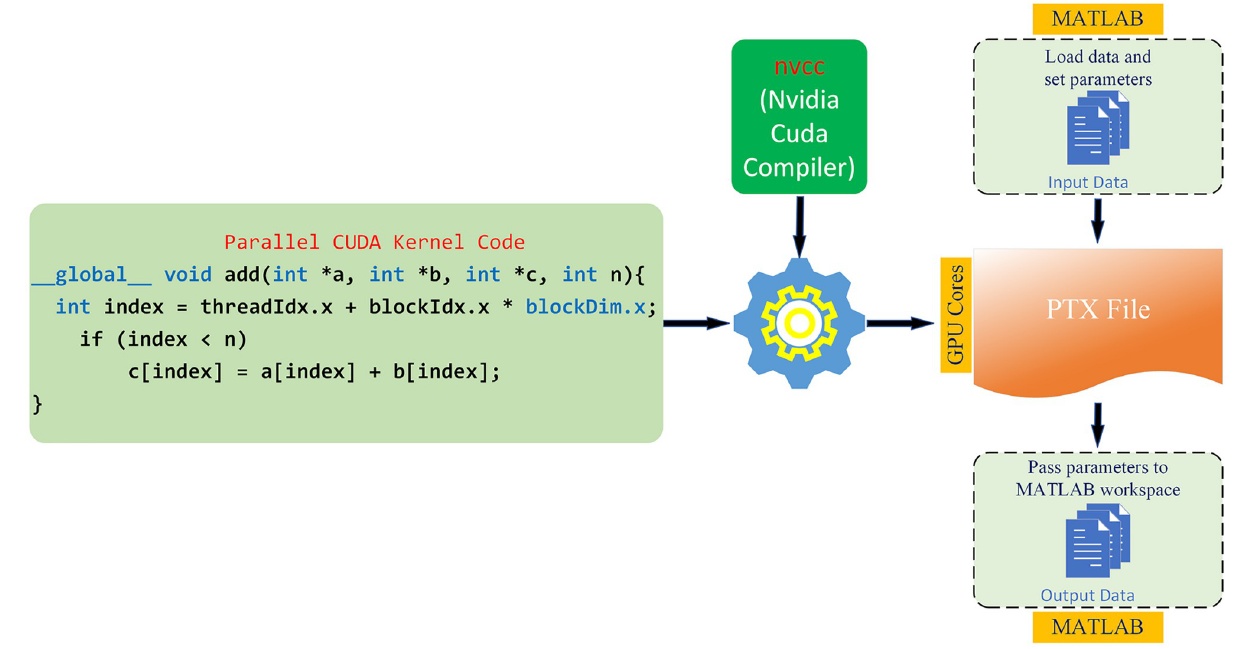
Fig 7. The diagram of parameter passing and communication architecture between